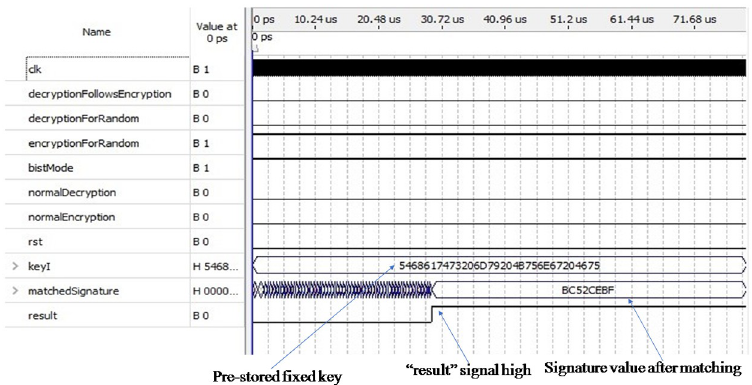
Fig 8. Simulation result of encryption module in test